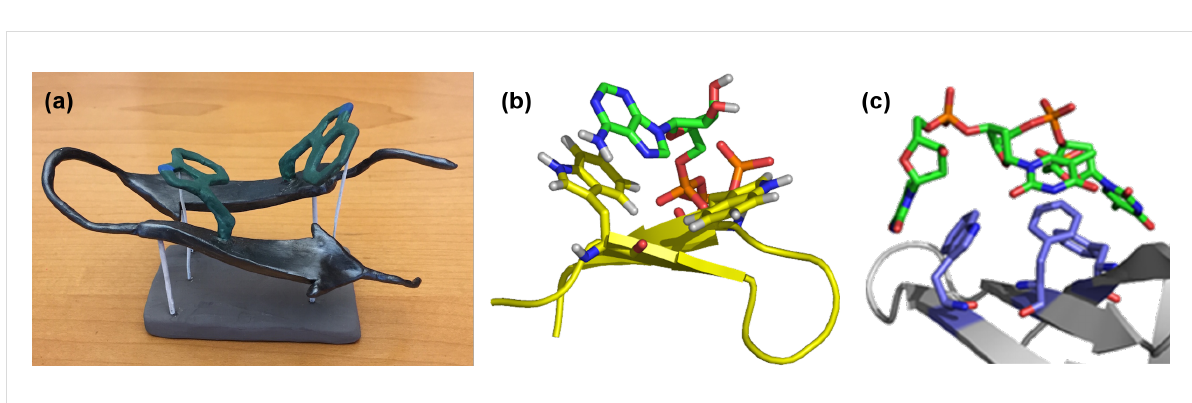
Figure 5: (a) A clay model of our WKWK peptide (aka “Saratide”) made by Jes Park, a former graduate student in the group (reproduced with permis- sion from Jessica Park). (b) Computational model of Saratide bound to ATP. (c) Inspiration from Nature: an OB fold bound to ssDNA.